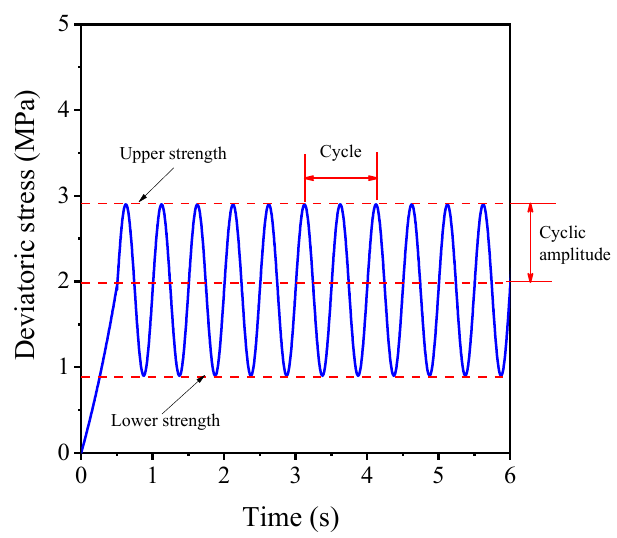
Figure 7. Loading waveform schematic.